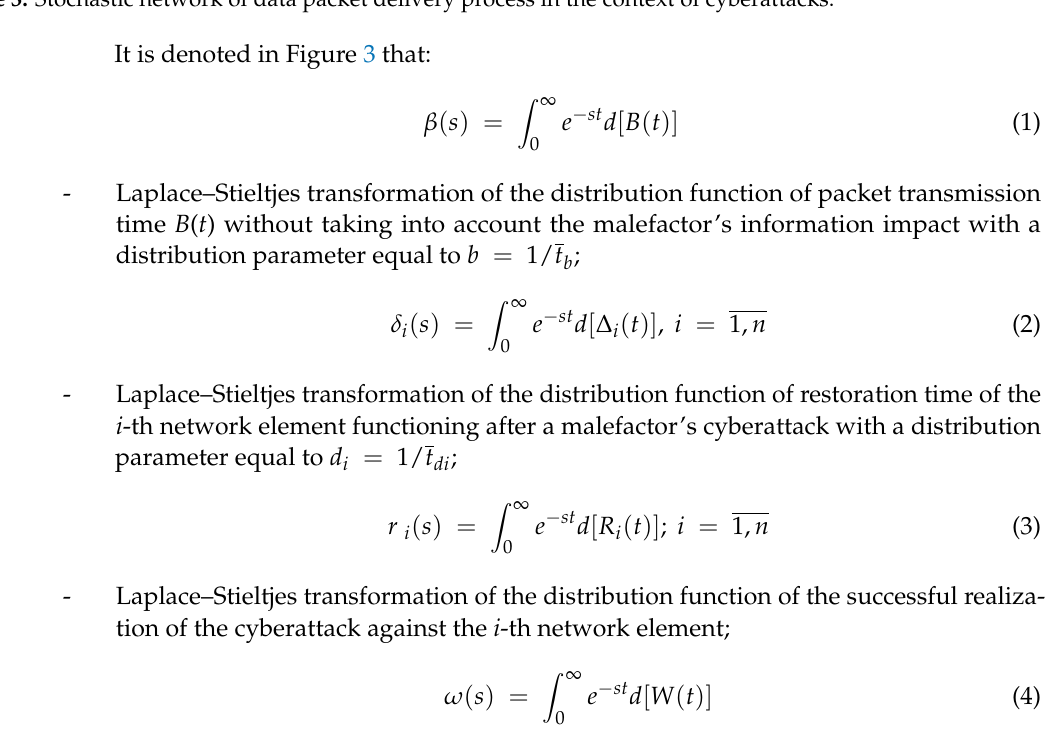
Figure 3. Stochastic network of data packet delivery process in the context of cyberattacks.